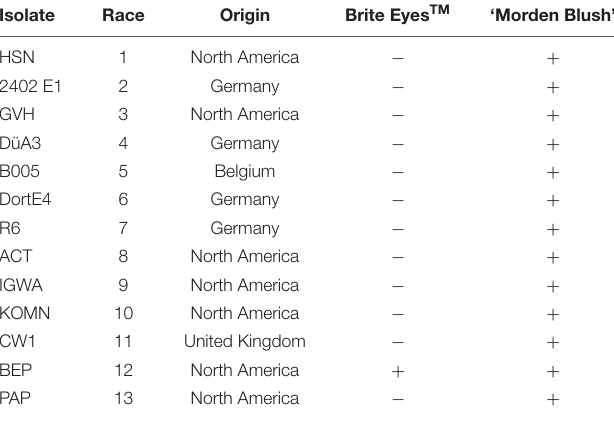
TABLE 1 | Phenotypes of Brite Eyes TM and ‘Morden Blush’ to 13 D. rosae isolates from North America and Europe. Phenotypes are recorded as resistant ( − ) or susceptible ( +